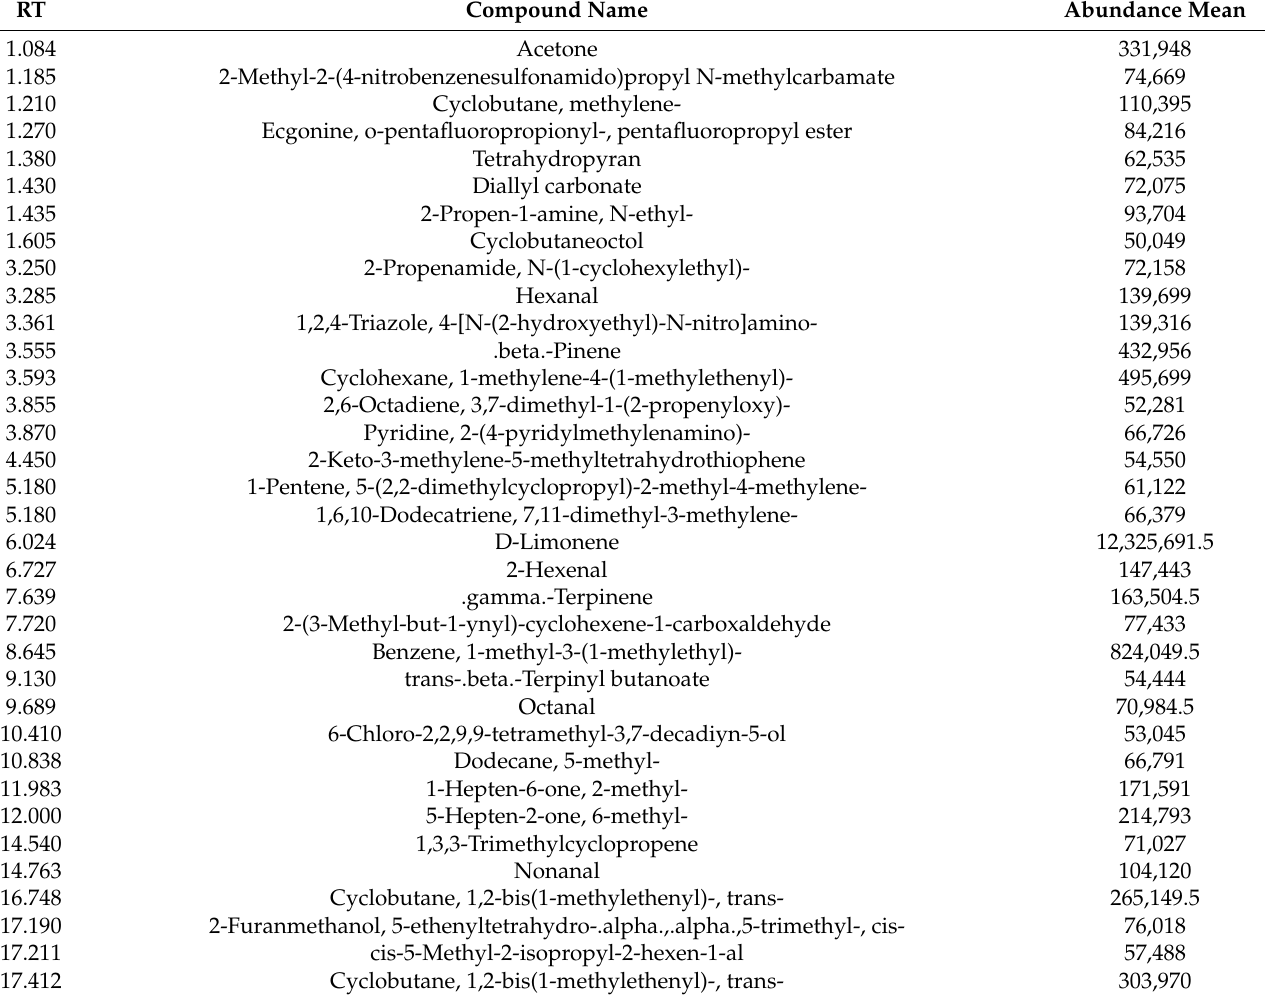
Table A9. Results for the SBL sample fingerprint determination with indication of the retention time (RT) and abundance mean for every identified